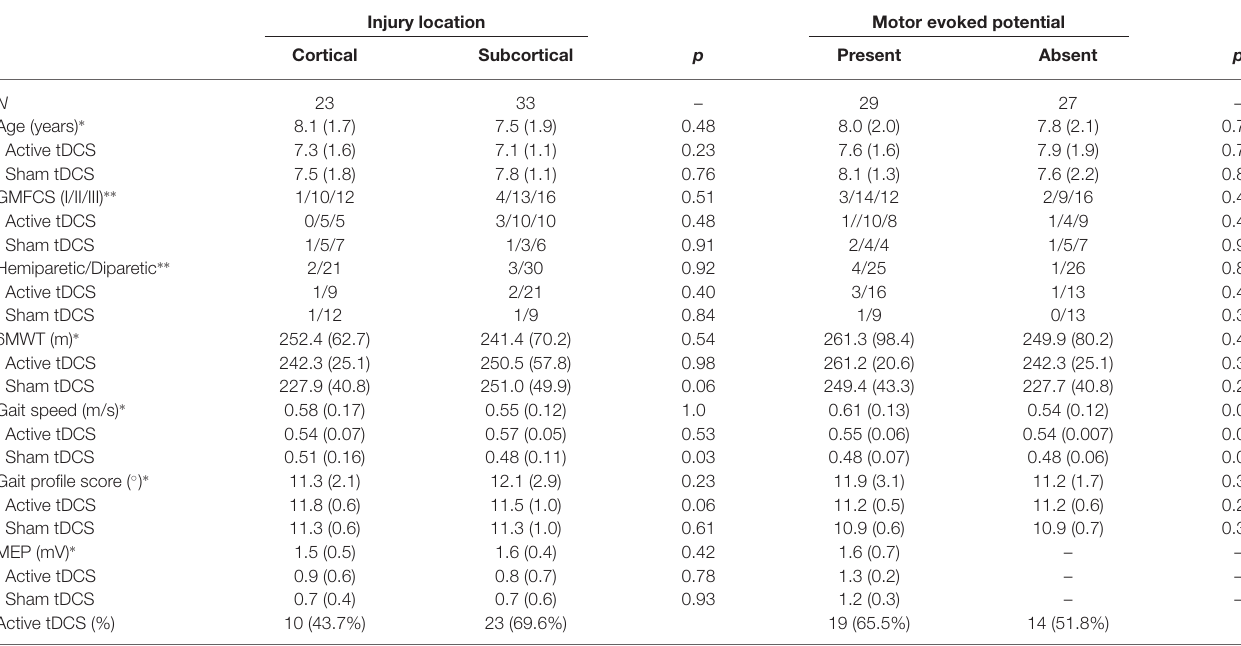
Legend: GMFCS, gross motor function classification system; tDCS, transcranial direct current stimulation; 6MWT (m), six-minute walk test; MEP, motor evoked potential. ∗ Data expressed as mean and standard deviation. Analyses performed with unpaired t-test. ∗∗ Numbers indicate frequency (n) of children in each group. Analyses performed with